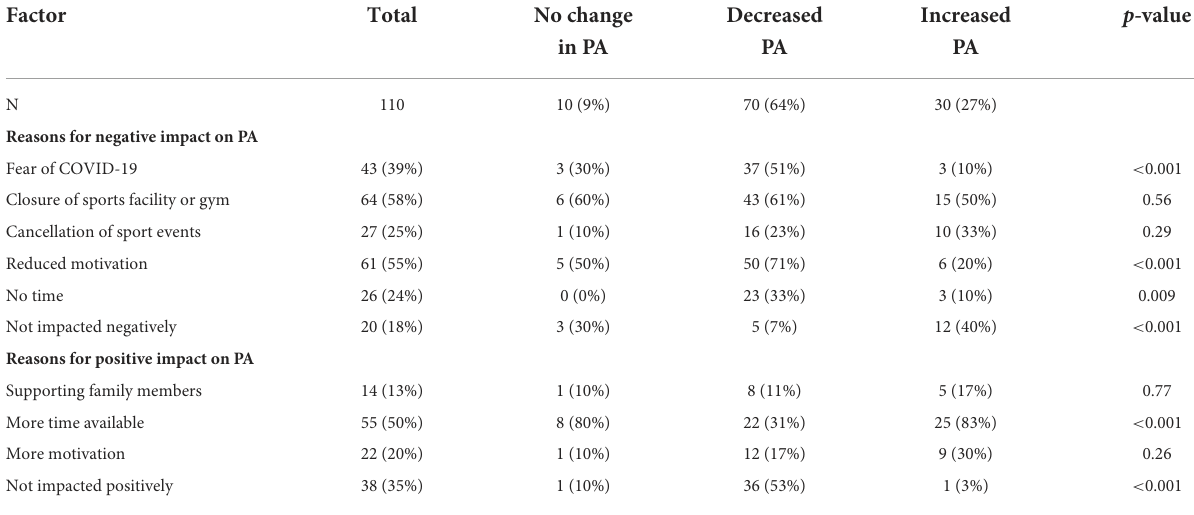
TABLE 4 Perceived positive and negative factors influencing levels of physical activity # . Factor Total No change